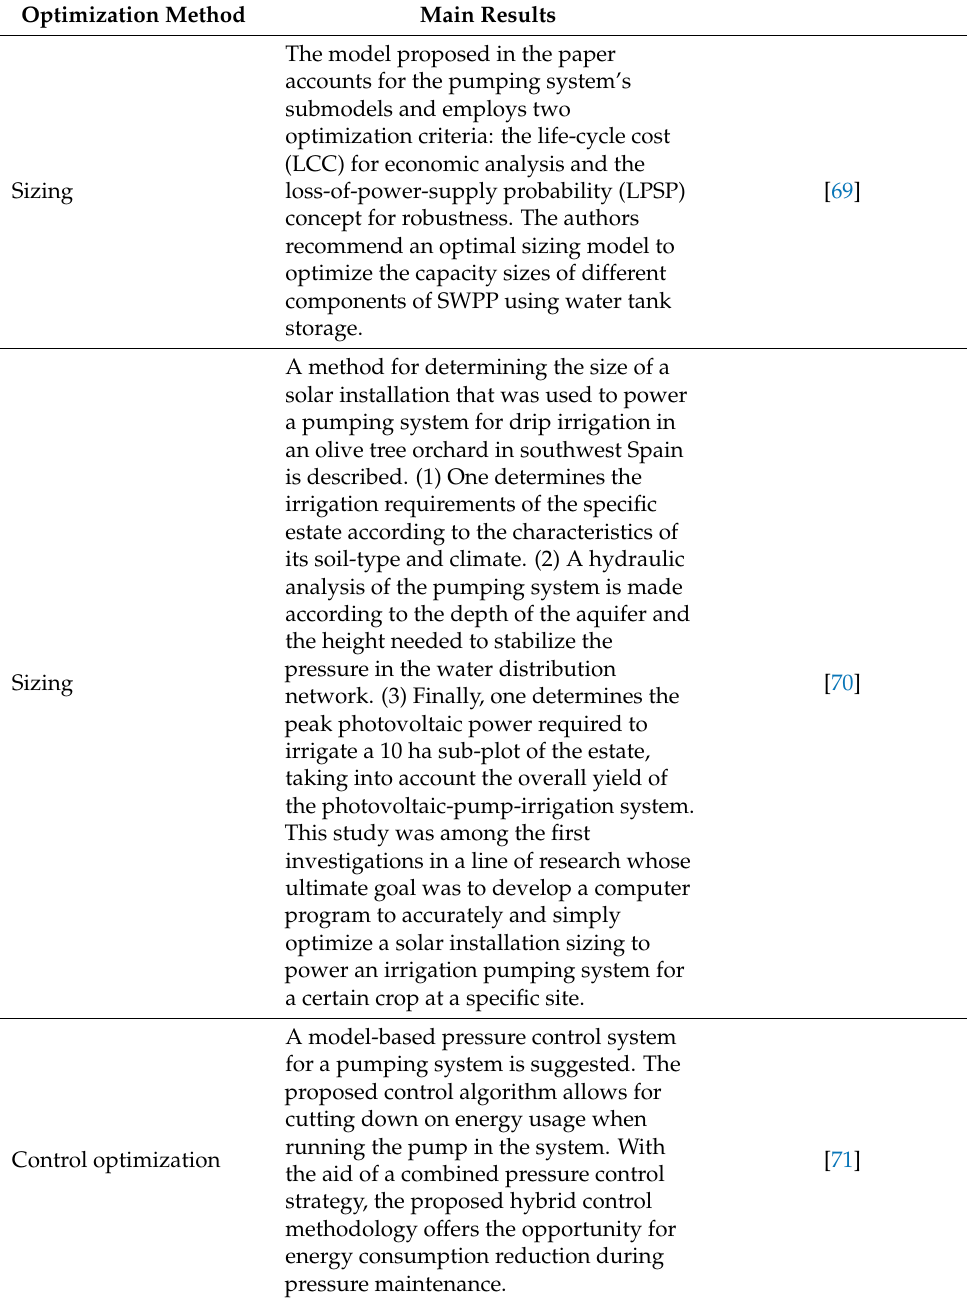
Table 8. Application of different optimization methods for pumping